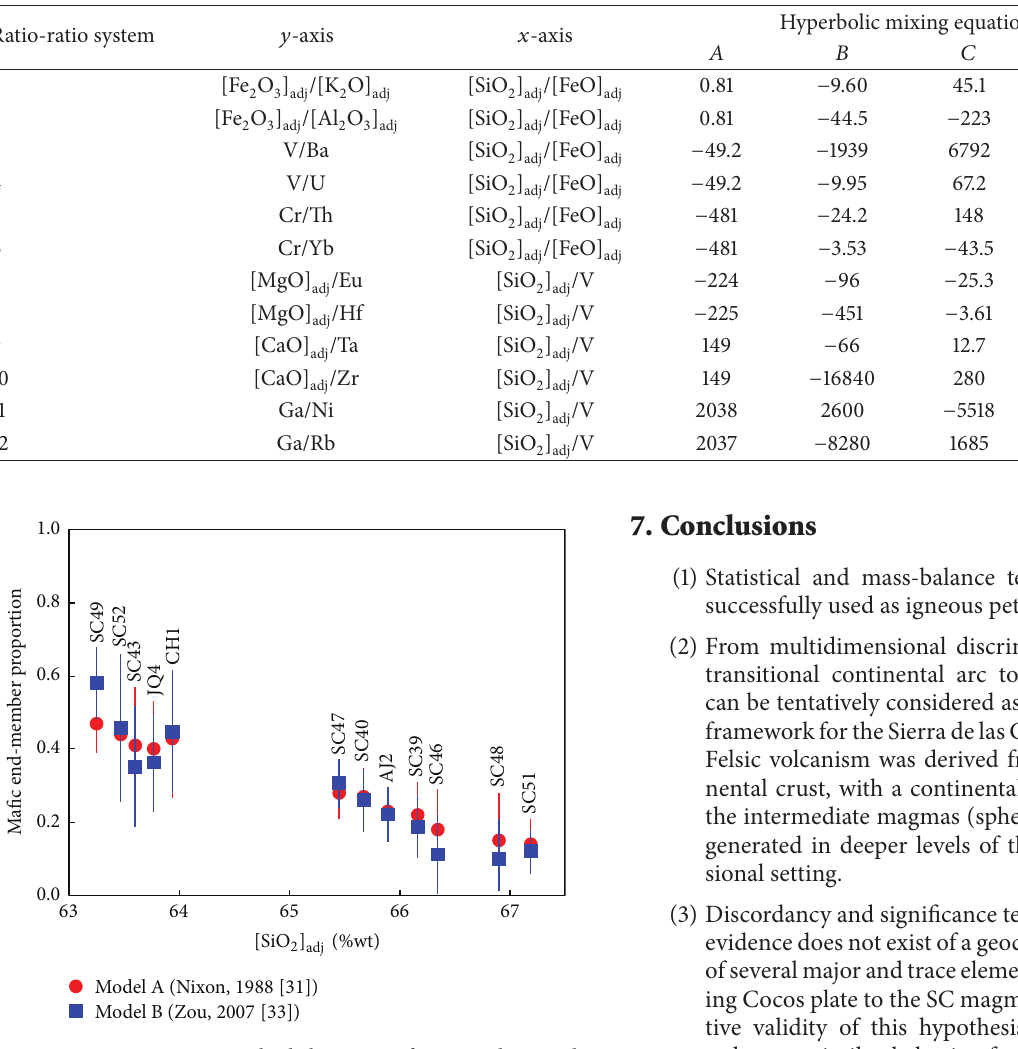
Figure 14: Mean ± one standard deviation of intermediate end- member proportions (N1) in the comingled lavas (N2) from the , produced by Sierra de las Cruces northern sector versus [ SiO 2 ] adj the incomplete mixing of N1 and N3 end-members: (a) red filled circle and line calculated ( 𝑛 = 11 ) from the mass-balance approach proposed by Nixon [31] and (b) blue filled square and line calculated ( 𝑛 = 12 ) from the mass-balance approach proposed by Zou